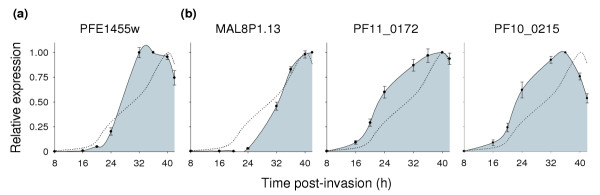
Stage-dependent gene expression of MFS-related transporters, throughout the intraerythrocytic cycle of P. falciparum. (a) A member of the glycoside-pentoside-hexuronide:cation symporter family; (b) the three P. falciparum members of the folate-biopterin transporter family. Both transporter families are distantly related to the MFS. The analysis was carried out as described in the legend to Figure 4.